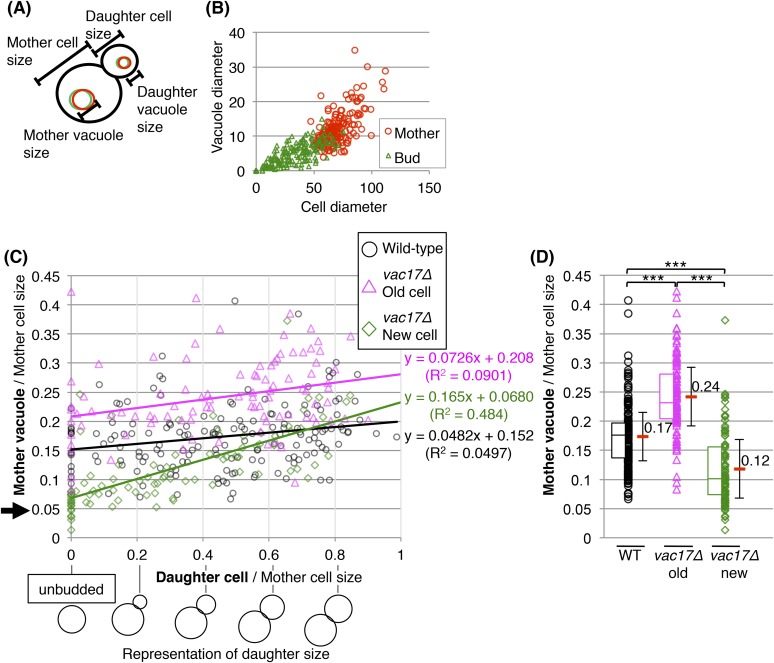
Yeast require vacuoles of a specific size prior to formation of a bud.(A) Schematic of diameters measured. (B) Vacuole diameter is proportional with the cell diameter. Scatter plot of cell diameter and vacuole diameter in mother and daughter cells. (C) When viewed across the cell-cycle, the increase in vacuole size of vac17Δ new cells is greater than either wild-type or vac17Δ old cells. Trend lines from linear equations of data from wild-type (black line); vac17Δ old mother cells (pink line), and vac17Δ new mother cells (green line) are shown. (D) Vacuole inheritance is important for regulating vacuole size in the mother cell. The vacuole size of vac17Δ old mother cells is larger than that of wild-type. Average in each category (red bar). Error bar; SD. *** (p-value < 1 × 10−4). Middle line in box plot indicates the median of the data set. The upper edge of the box indicates the 75th percentile of the data set, and the lower edge indicates the 25th percentile.